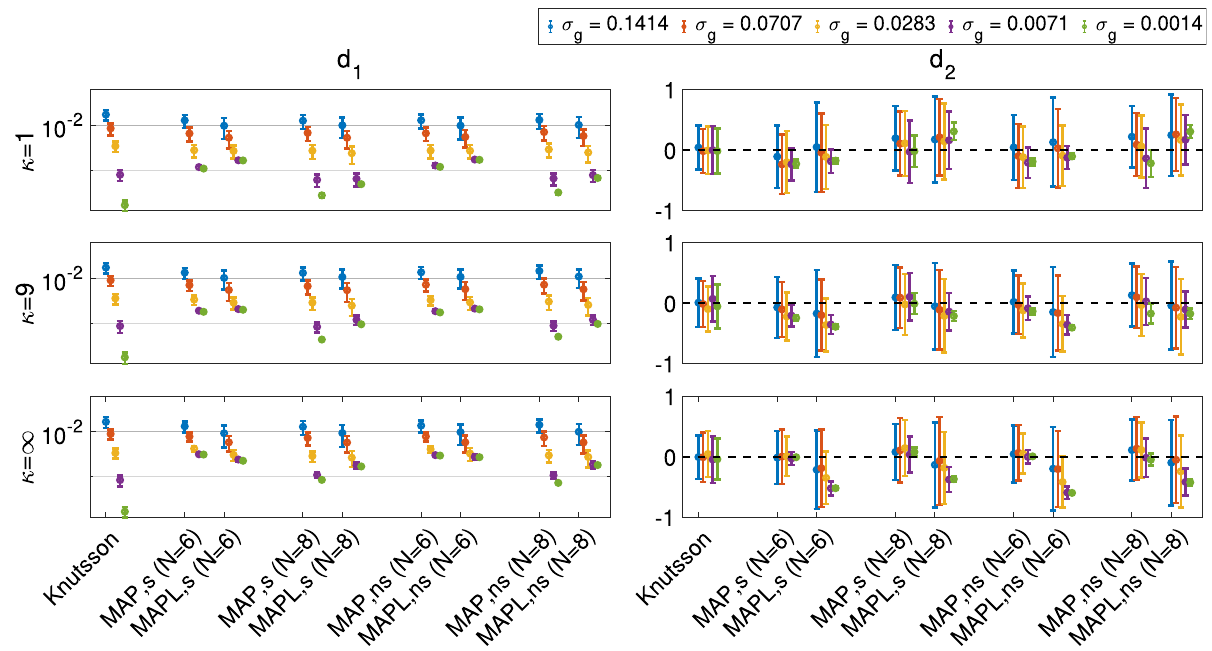
8 ) point sets in the presence of five × there is no = ∞